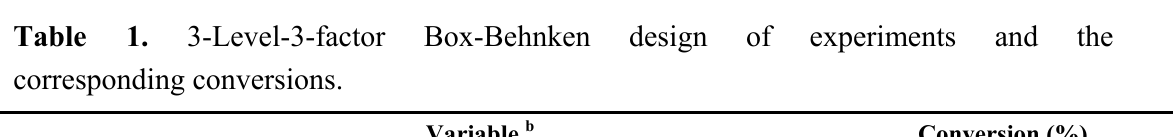
1. 3-Level-3-factor Box-Behnken design of experiments and